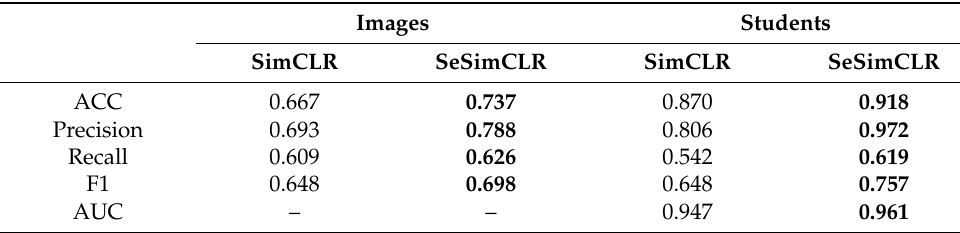
Table 1. Five evaluation indexes were calculated on all 123 students to compare the classification per- formance of SimCLR with SeSimCLR. Note that SeSimCLR is the used subspace-enhanced SimCLR.